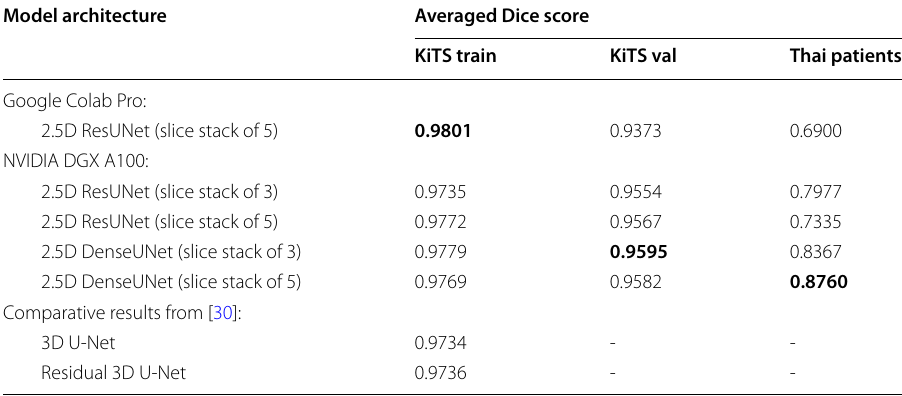
The best result regarding each column is highlighted in bold